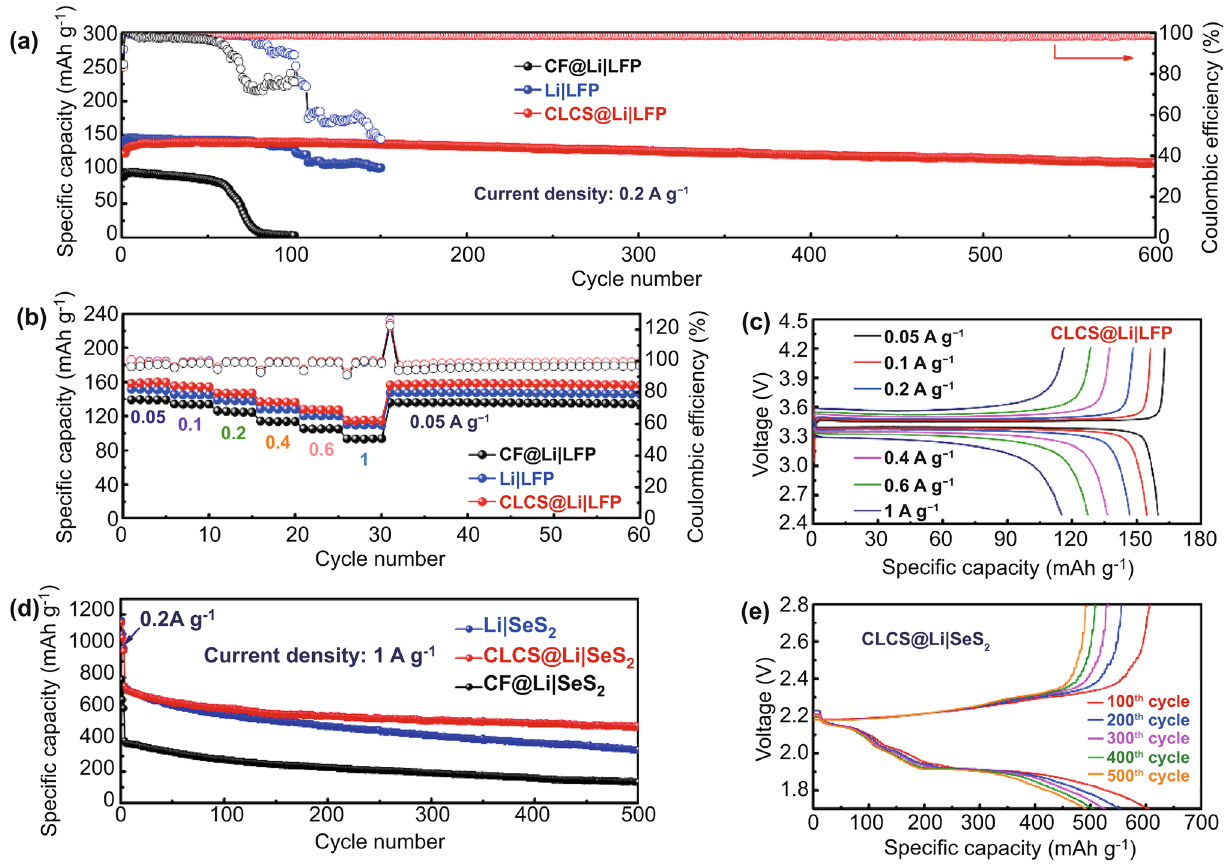
Fig. 5 a Cycling performance of Li|LFP, CF@Li|LFP and CLCS@Li|LFP full cells at a current density of 0.2 A g −1 . b Rate performance at var- ious current densities from 0.05 to 1 A g −1 and c related galvanostatic charge–discharge profiles. d SeS 2 -based full cells coupled with Li, CF@Li and CLCS@Li anode at 1 A g −1 . e Corresponding galvanostatic charge–discharge profiles at different